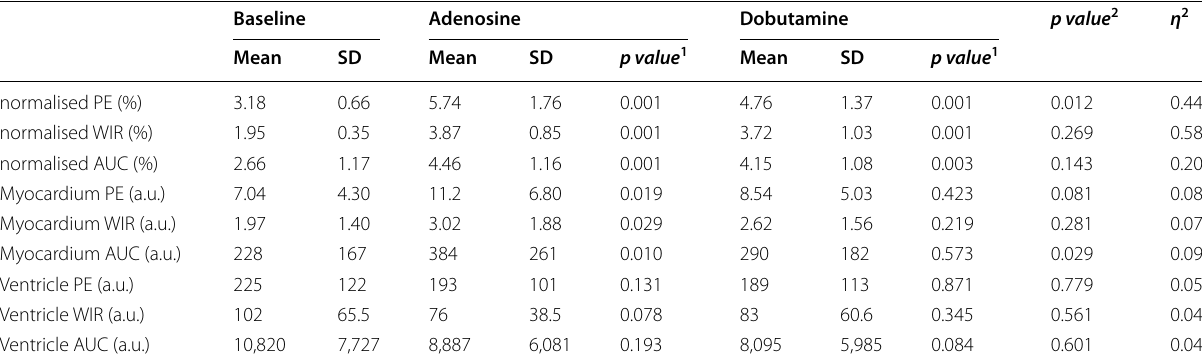
Table 3 Myocardial contrast echocardiography measurements in eight rats, each under baseline conditions, and under adenosine